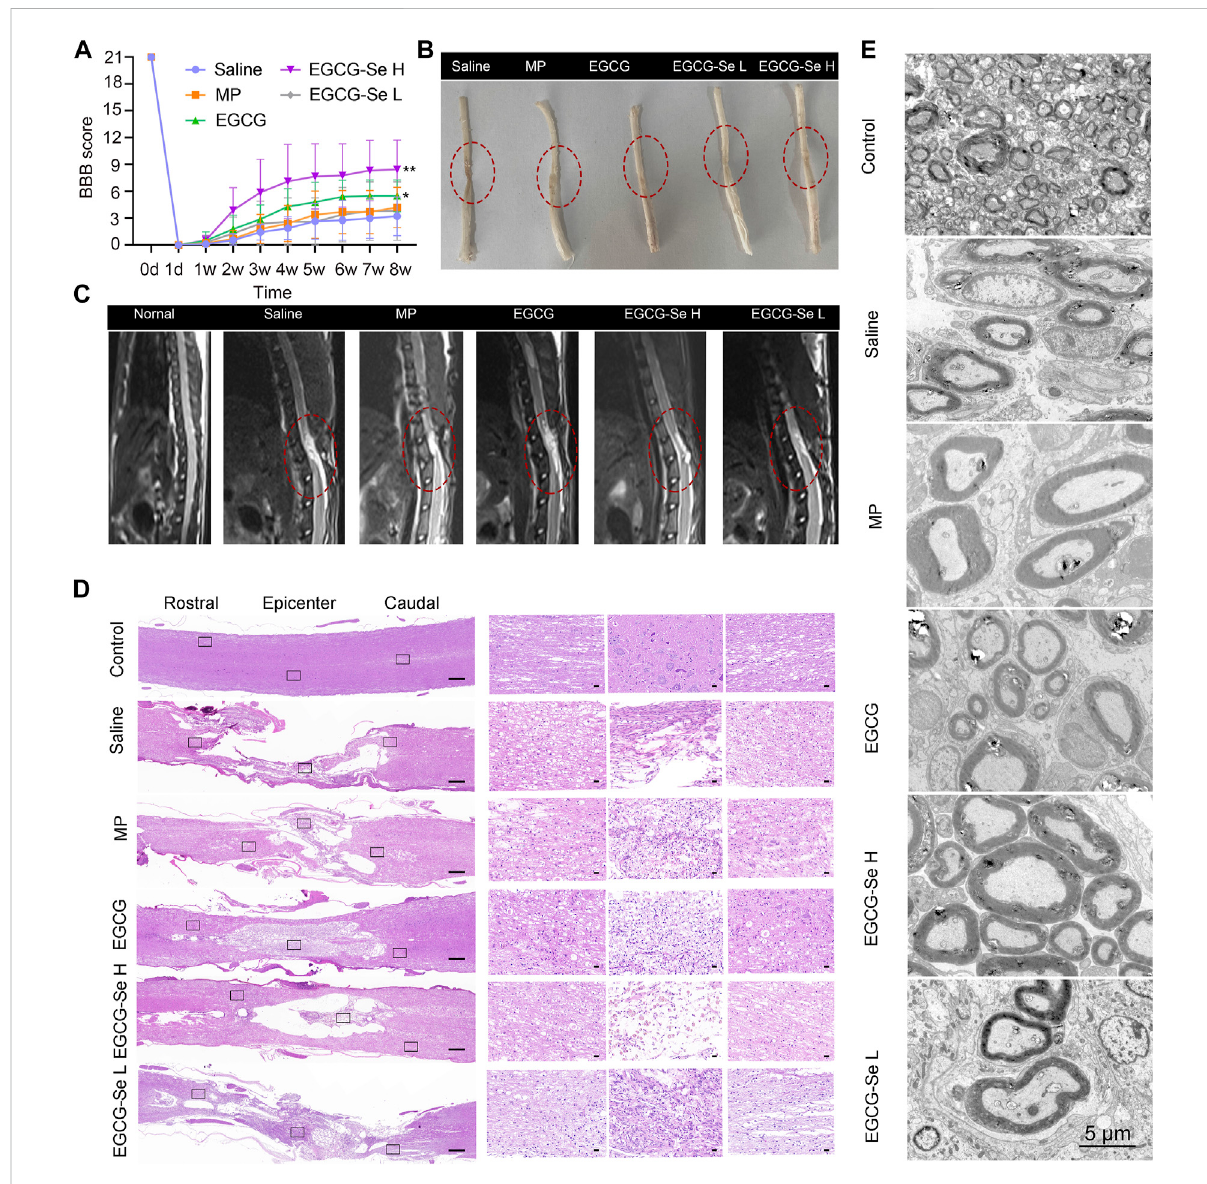
FIGURE 4 Assessment on the recovery of motor function after spinal cord injury (SCI). (A) Basso, Beattie, and Bresnahan (BBB) scores of SCI rats treated with saline, methylprednisolone sodium succinate, 9.5 mg/kg epigallocatechin-3-gallate (EGCG), 5 mg/kg EGCG-Se nanoparticles (NP), or 10 mg/ kg EGCG-Se NP. ** p < 0.01, * p < 0.05, in comparison with thesaline group. (B) Images of the spinal cord in different treatment groups 8 weeks after SCI. The lesion of spinal cord injury is indicated in the red dashed circle. (C) T2-weightedsagittal magnetic resonanceimagesof the spinal cord following different treatments, in which the red oval represents the injury site. (D) Representative hematoxylin-eosin staining images of spinal cord tissue.Theblackrectangleontheleftshowsthesmallimageontherightafterzoomingin.Scalebarsare500 μ m(left)and50 μ m(right),respectively. (E) Representative transmission electron microscopic images of myelin sheath ultrastructure. Scale bar = 5 μ